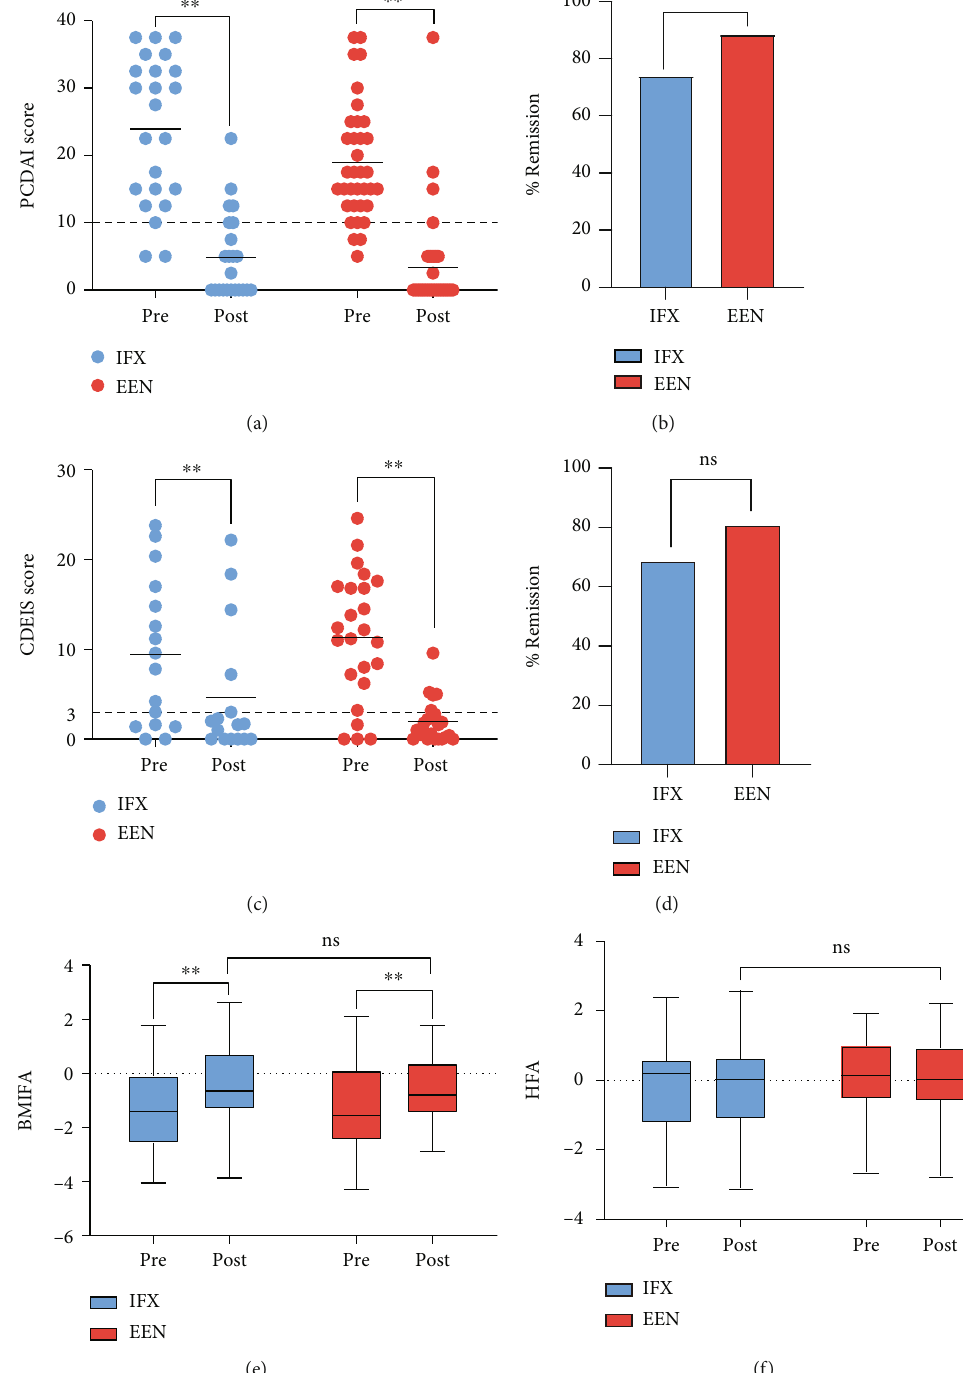
Figure 1: Comparisons of short-term disease outcomes among the two groups after induction remission therapy. (a) PCDAI scores and (c) CDIES scores of IFX- or EEN-treated patients at pre and postinduction therapy. Paired Student ’ s t -test. Percentage of (b) IFX- or (d) EEN- treated patients in clinical remission ( PCDAI < 10 ) and endoscopic remission ( CDEIS < 3 ) after induction remission strategies. (e) BMIFA and (f) HFA of patients treated with EEN or IFX at diagnosis and at the end of induction therapy. Chi-squared or Fisher ’ s exact test. ∗ P < 0 : 05 ; ∗∗ P < 0 : 01